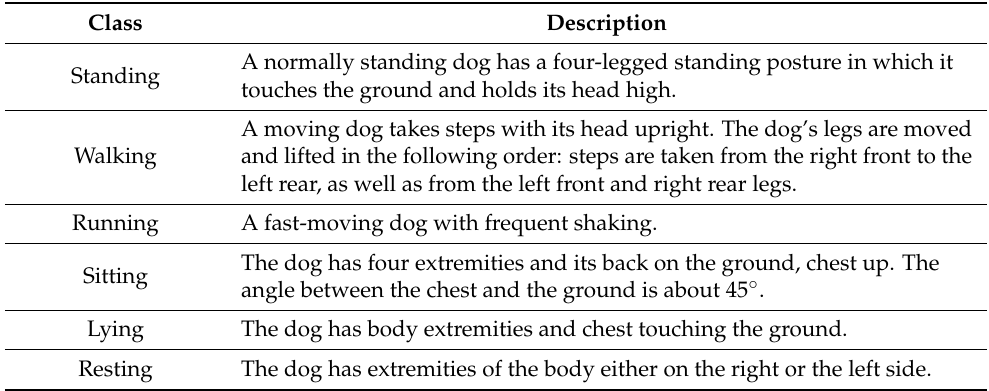
Table 1. Ethogram of the behaviors included in this